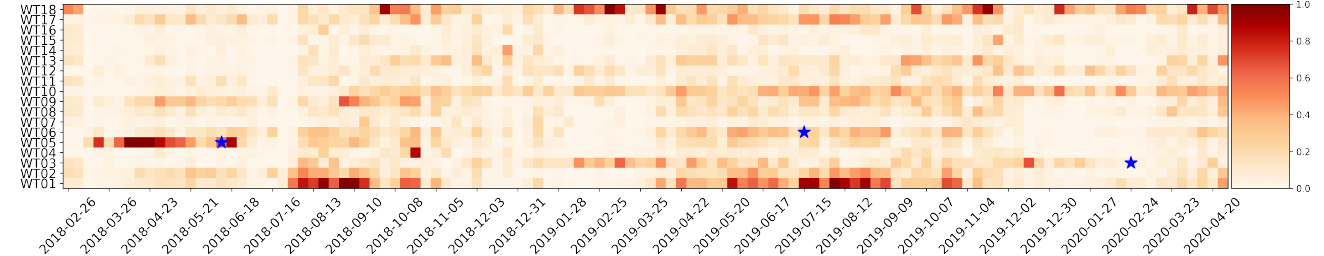
Figure 3. Main bearing health according to normal behavior model. Faults are marked with a blue star.